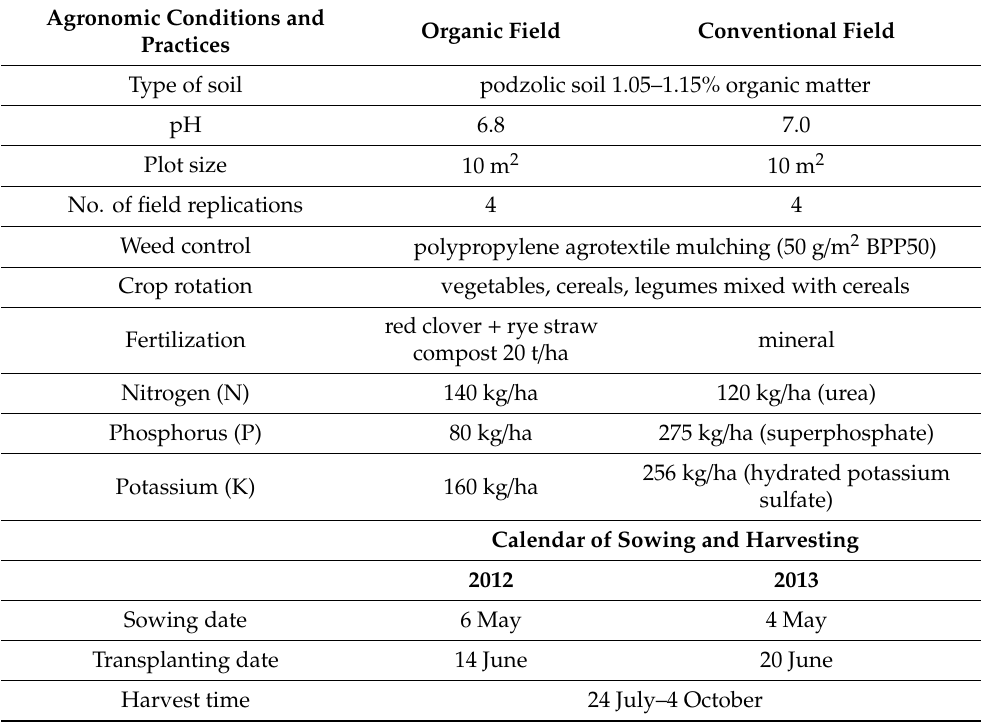
Table 1. Agronomic conditions and practices applied in the organic vs. conventional courgette cultivation.